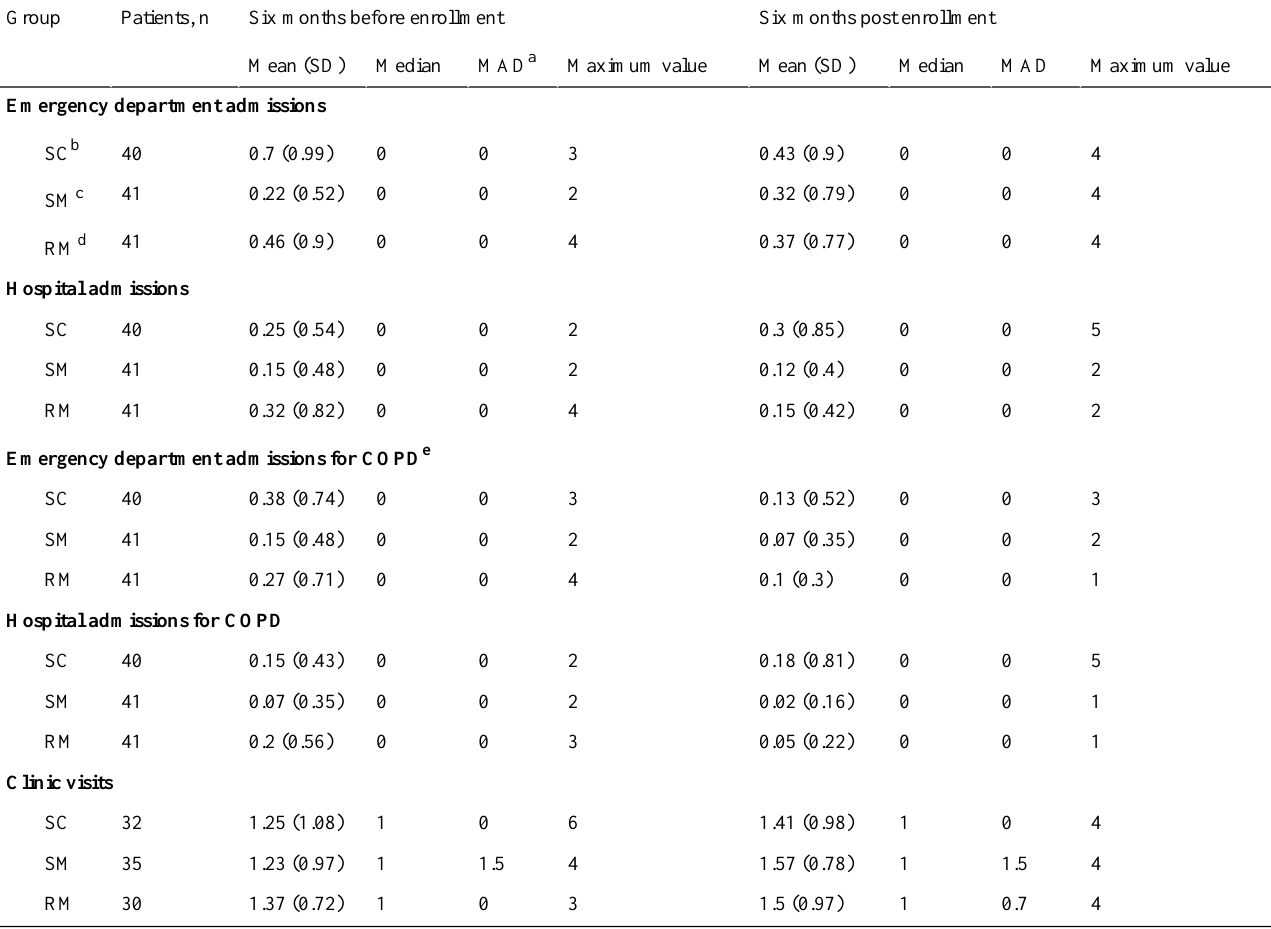
Table 2. Health care use based on hospital